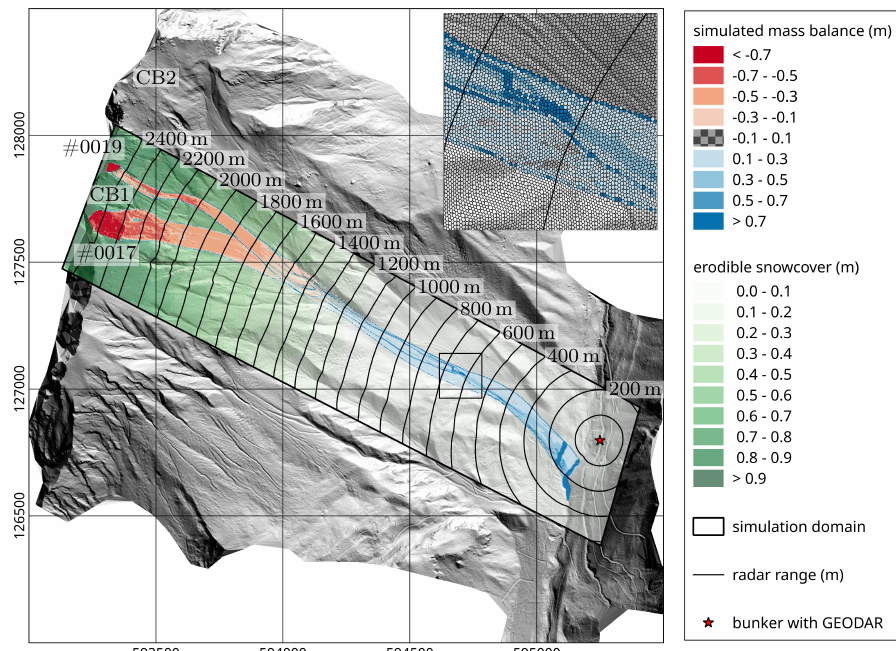
Figure 3. Overview of the avalanche test site Vallée de la Sionne (VdlS) with both simulated avalanches (#0017 lower release area, #0019 above) from release areas Crêta Besse (CB1/2). The simulated mass balance summarizing entrainment (red) and deposition (blue) of the two consecutive avalanches is shown, together with the entrainable snow cover (green) that linearly increases from 0–1 m above 1200 m range until the mountain top. Black contour lines indicate the radar range (distance from GEODAR in the valley floor). The area in the black square is zoomed in the upper right corner showing the computational mesh and the deposition patterns of both avalanches with the dark blue area corresponding to the runout of avalanche #0019. Coordinates are given the Swiss coordinate system CH1903 (SRID